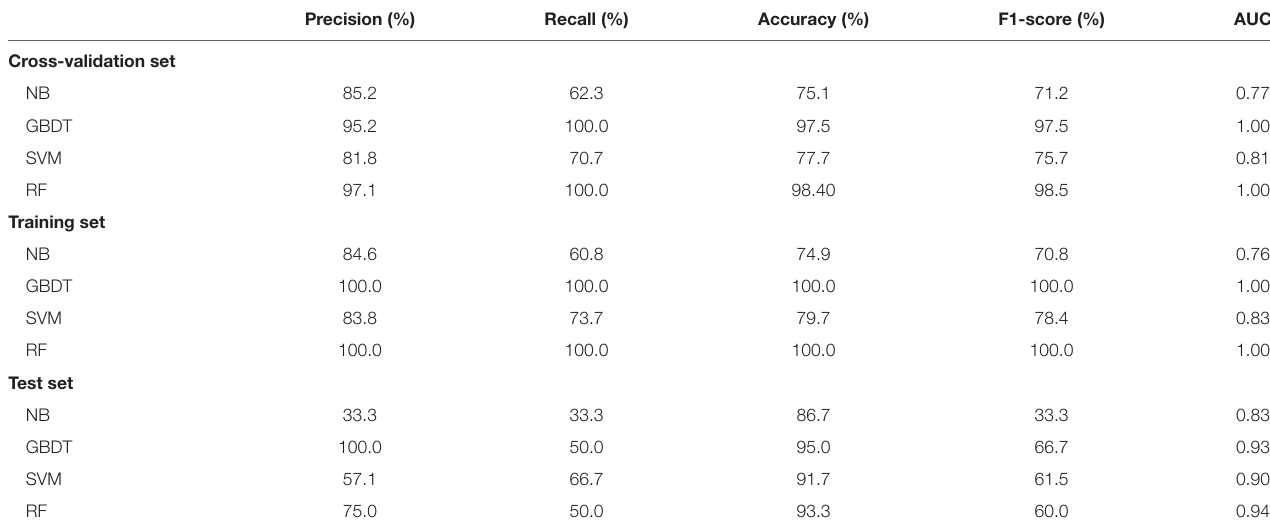
TABLE 2 | Model performance of the training and test